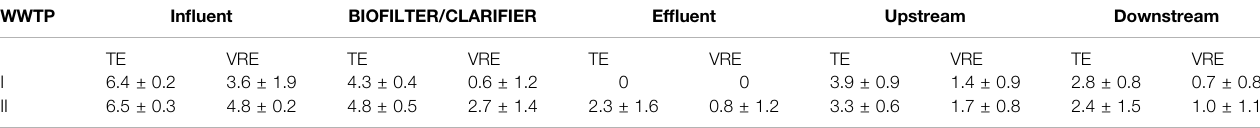
TABLE 3 | Mean counts of the presumptive enterococci of various sampling points expressed as Log 10 /100 ml values.